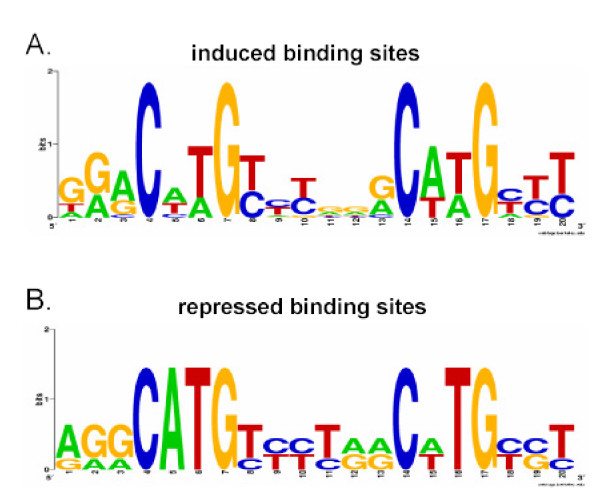
WebLogo multiple sequence alignment of p53 binding sites. Individual base letter height indicates level of conservation within each binding site position. A) Consensus sequence of p53-induced targets shown in Figures 4 and 5. B) Consensus sequence of p53-repressed targets shown in Figure 6.